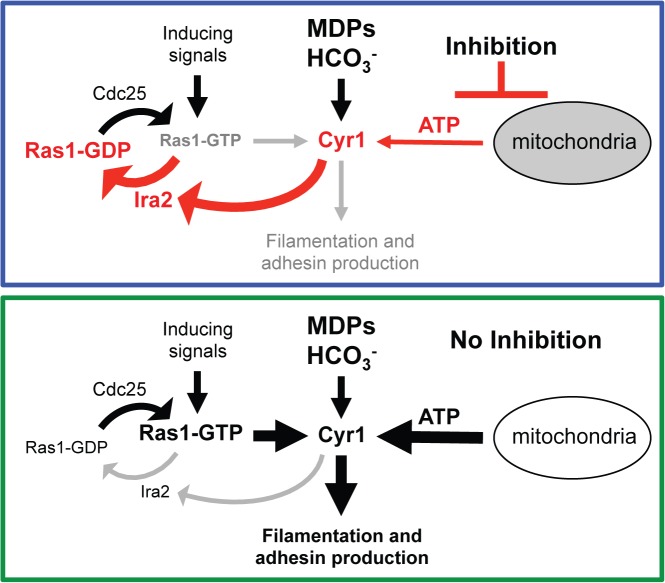
New model of the Ras1-Cyr1 signaling pathway.In the presence of MB or other respiratory inhibitors, cellular ATP levels are low. Under these conditions, GTP-bound Ras1 is rapidly turned over to GDP-bound Ras1 in a Cyr1-Ira2 dependent manner repressing the input of filamentation inducing signals and hyphal formation does not occur (upper panel). Under control conditions (no inhibition) ATP levels are high due to efficient oxidative metabolism and slow growth. In the presence of inducing signals GTP-bound Ras1 can accumulate probably because Cyr1 does not stabilize the interaction of Ras1 with Ira2. GTP-Ras1 can now effectively bind to and activate Cyr1 resulting in filamentation (lower panel). MDPs: muramyl dipeptides; HCO3
¯: bicarbonate.